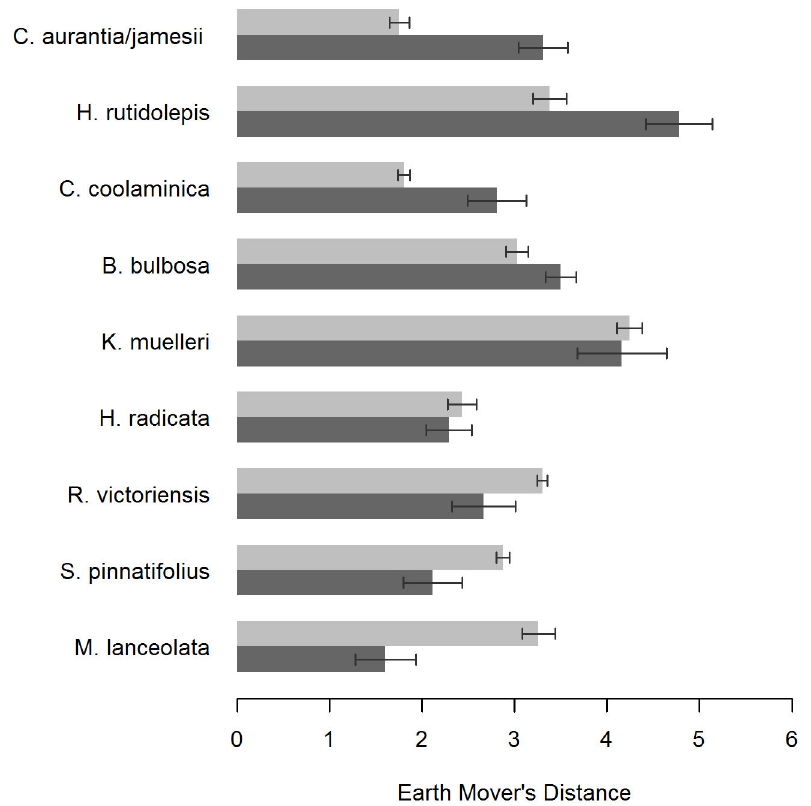
Figure 2. Flower colour difference between species in the field and two invasive species. Pairwise mean flower colour difference (measured as the Earth Mover’s Distance) was calculated between individual yellow-orange flowers of different species and mean colour of individuals of H . aurantiacum (light bars) and H . praealtum (dark bars). 95% confidence intervals are shown. doi: